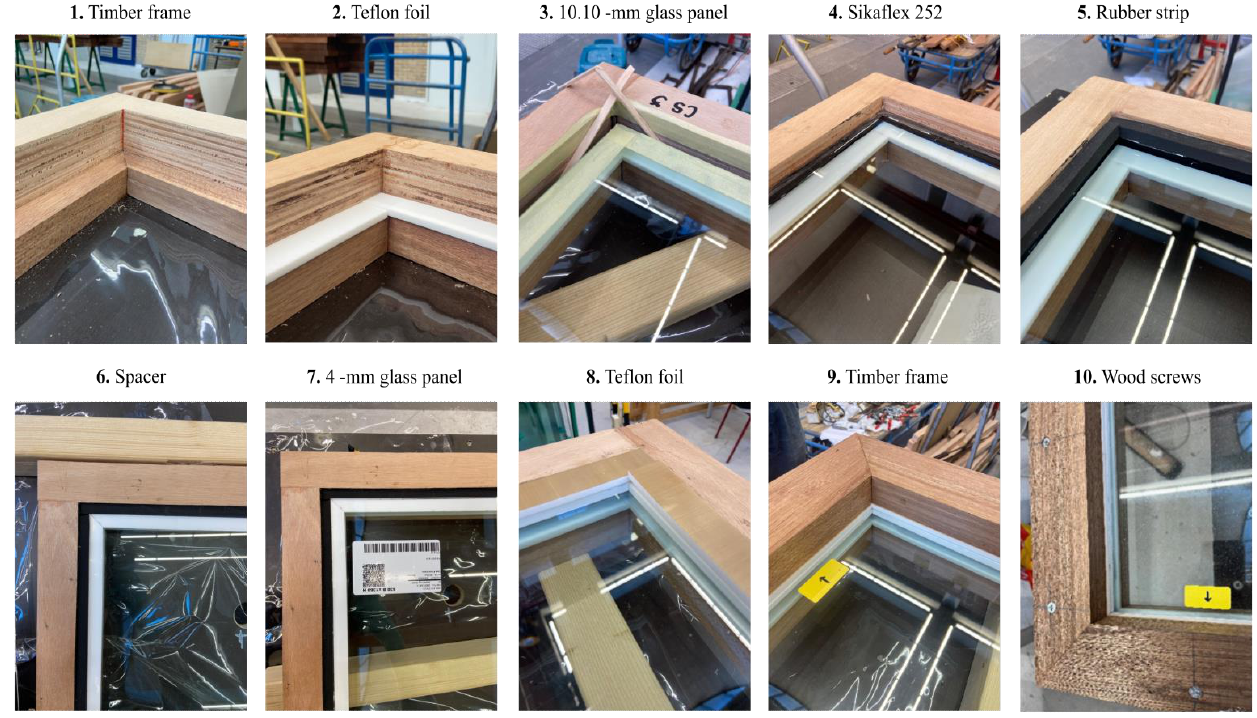
Figure 2. Overview of the structural glass window construction.